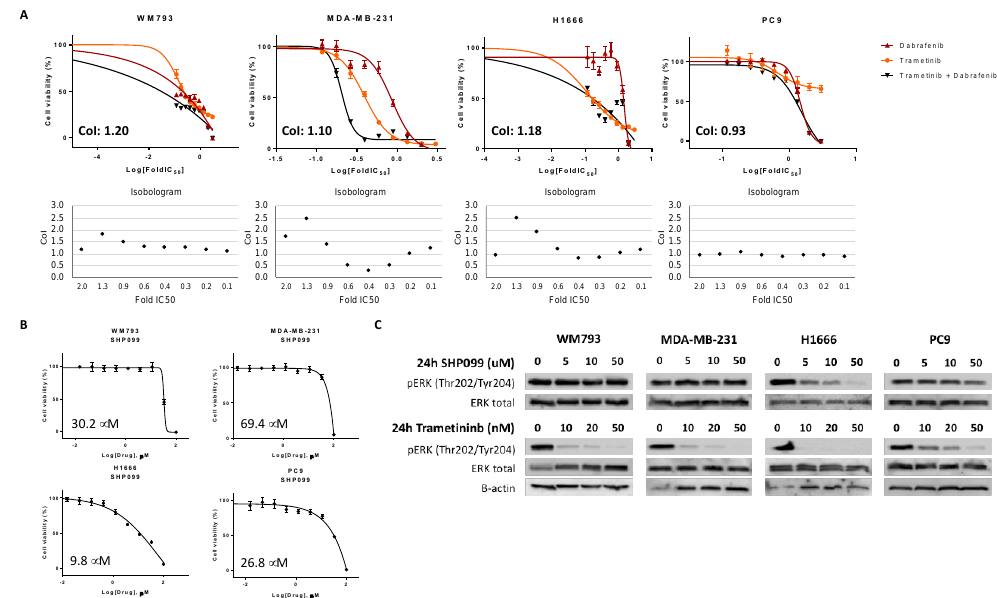
intermediately sensitive to SHP2 inhibition compared to the other cell lines, with IC 50s of 30.2 and 26.8  M, respectively. A different SHP2 inhibitor, RMC-4550, showed similar results in the class II and class III BRAF -mutant cell lines, with slightly lower IC 50s of 63.0  M in the class II and 3.1  M in the class III BRAF -mutant cell line, as shown in Table 2 and Figure S1. Hereafter, we checked the effect of different concentrations of single SHP2 and single MEK inhibition on downstream ERK activation using immunoblotting experiments. Figure 3C indicates that single trametinib treatment can completely inhibit phosphorylation of ERK at Thr202/Tyr204, in all BRAF mutant cell lines. In the PC9 cell line, a higher concentration of trametinib is needed to inhibit ERK activation, consistent with the lack of alterations—and therefore sensitivity to inhibition—in the MAPK pathway. Treatment with increasing doses of SHP099 reveals that ERK phosphorylation is not inhibited in the class I, II, and WT cell line, and therefore explains that single SHP2 inhibition is not effective enough to inhibit cell viability. In contrast, SHP099 inhibits ERK phosphorylation in the class III BRAF mutant cell line H1666. This finding explains why this cell line is more sensitive to cell growth inhibition after single SHP2 treatment.